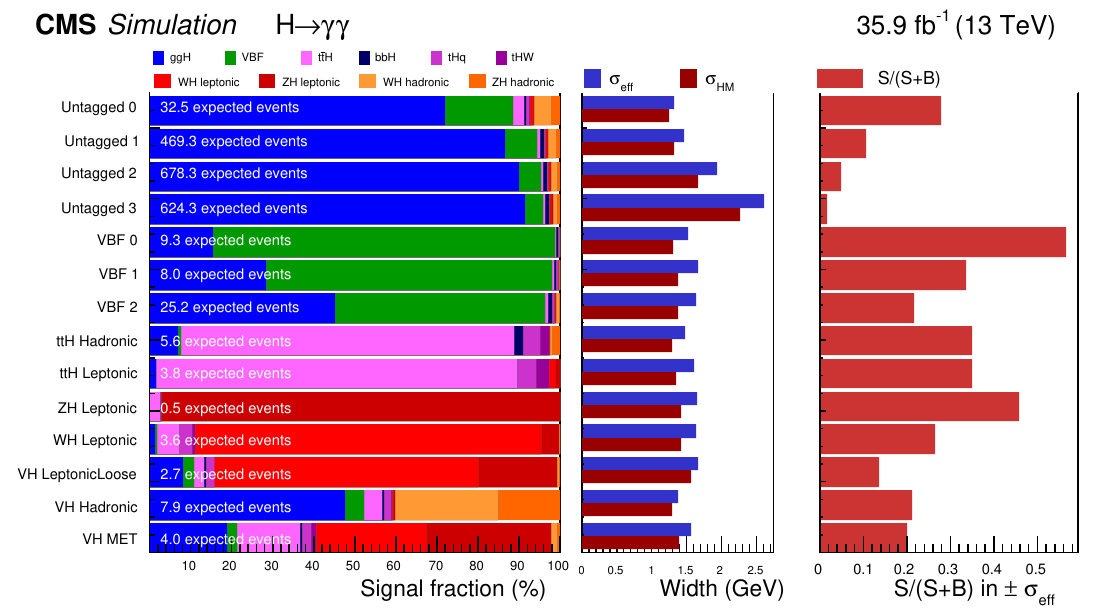
Figure 15 . Expected fraction of signal events per production mode in the di(cid:11)erent categories. For each category, the (cid:27) e(cid:11) and (cid:27) HM of the signal model, as described in the text, are given. The ratio of the number of signal events (S) to the number of signal-plus-background events (S+B) is shown on the right hand